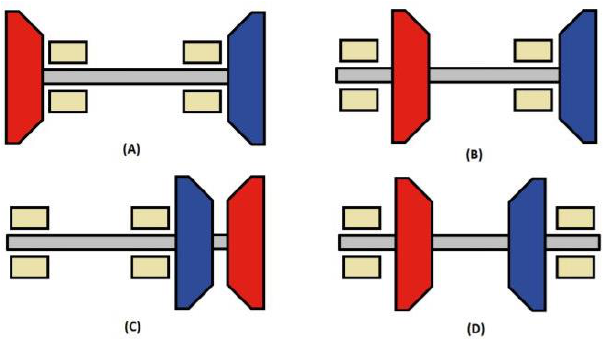
Fig. 1. The different bearing arrangements in a turbocharger